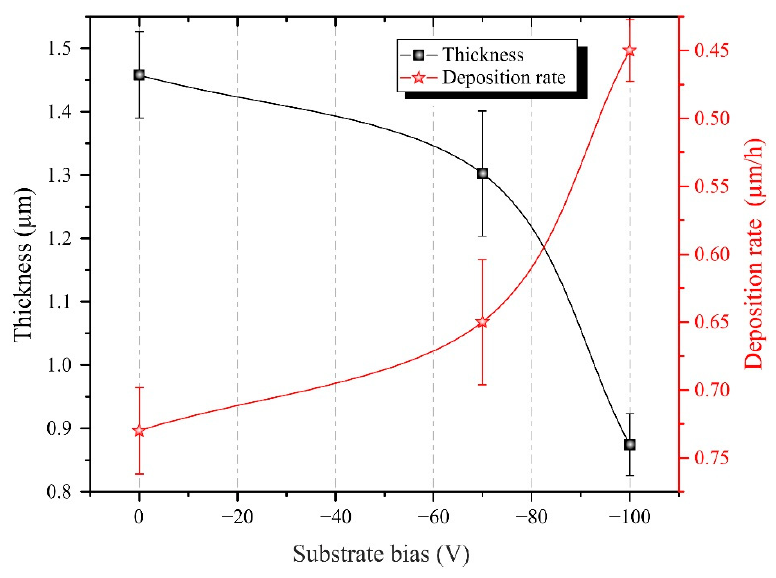
Figure 1. Dependence of DR and thickness of TiCN coating on U s .